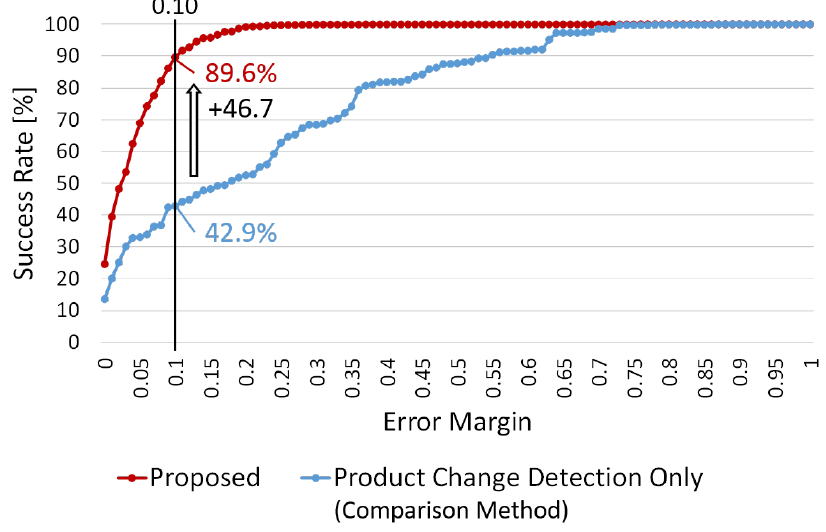
Figure 13. Average success rate for on-shelf availability for all the shelves at various error margins in experiment